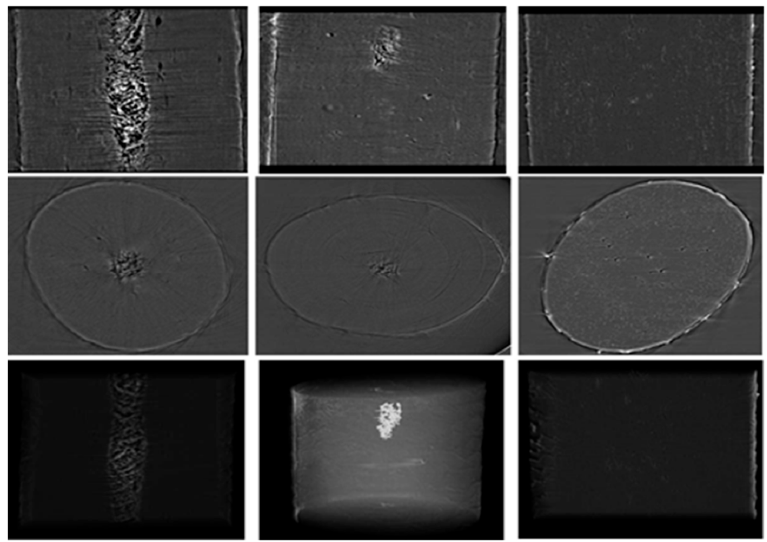
Figure 3. Synchrotron X-ray nanoscopic images of the hair samples. In this figure, the three rows show projection ( upper ), axial ( middle ) and 3D rendering ( lower ) images, respectively. The medulla of a healthy hair, and the distribution of discontinuous or complete medulla loss in a cancer hair are shown in the columns from the right to left, respectively (reprinted with permission from [13]).